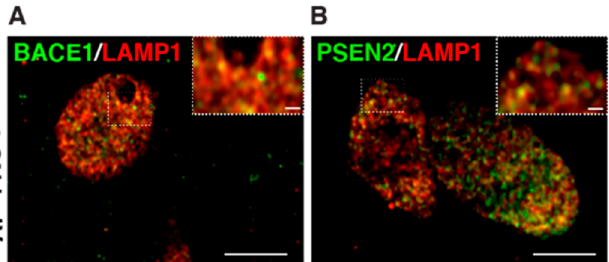
Figure 4. Examination of BACE1 and PSEN localization in axonal dystrophies of AP-4 ε KO mice, at high resolution (A,B) Representative airyscan images of LAMP1 with BACE1 ( A ) and PSEN2 ( B ) showing most BACE1 and PSEN2 vesicles in the axonal swellings are also LAMP1-positve, unlike what is observed with ATG9 and LAMP1. Scale bar: 5 μ ; inset 1 μ .